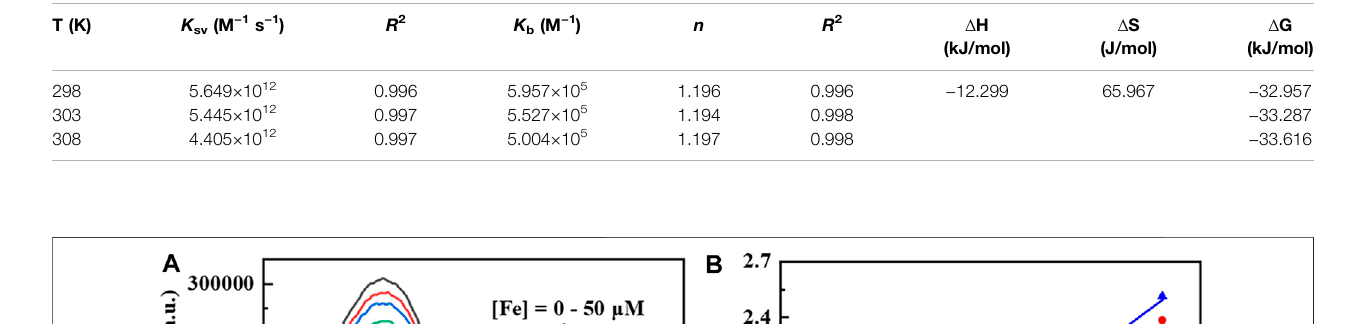
TABLE 1 | Binding constant ( K b ) and number of average binding sites ( n ) of the Fe complex with DNA at different temperatures.